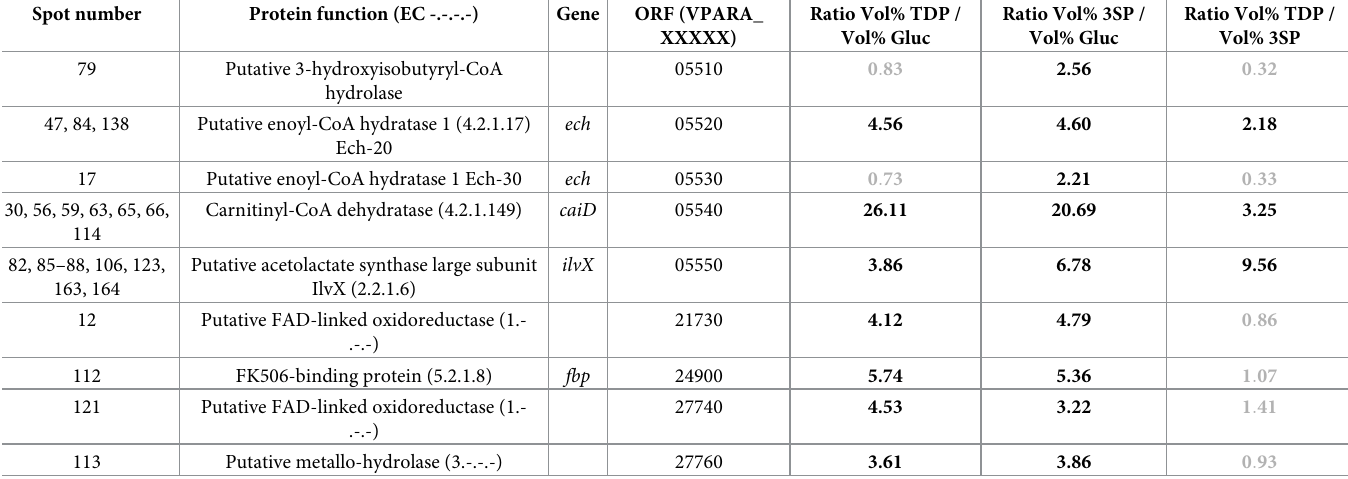
Table 4. Proteins identified via proteome analysis exhibiting an increased spot volume during cultivation of V . paradoxus TBEA6 with 3,3´-thiodipropionic acid (TDP) or 3-sulfinopropionic acid (3SP) in comparison to gluconate (Gluc). The table includes the spot numbers in the 2D gels (S1–S3 Figs), the protein function and the locus tag. The highest relevant ratios of mean normalized spot volumes are indicated in black; insignificant ratios are displayed in grey. Spot number Protein function (EC -.-.-.-)